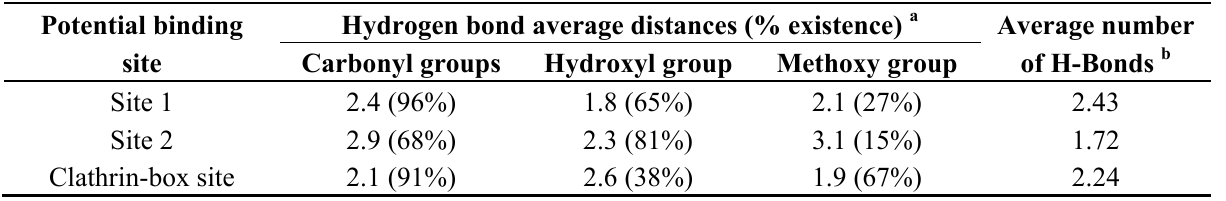
Table 3. Summary of the hydrogen bond contacts between 1 and potential binding sites at the CTD over the course of the MD